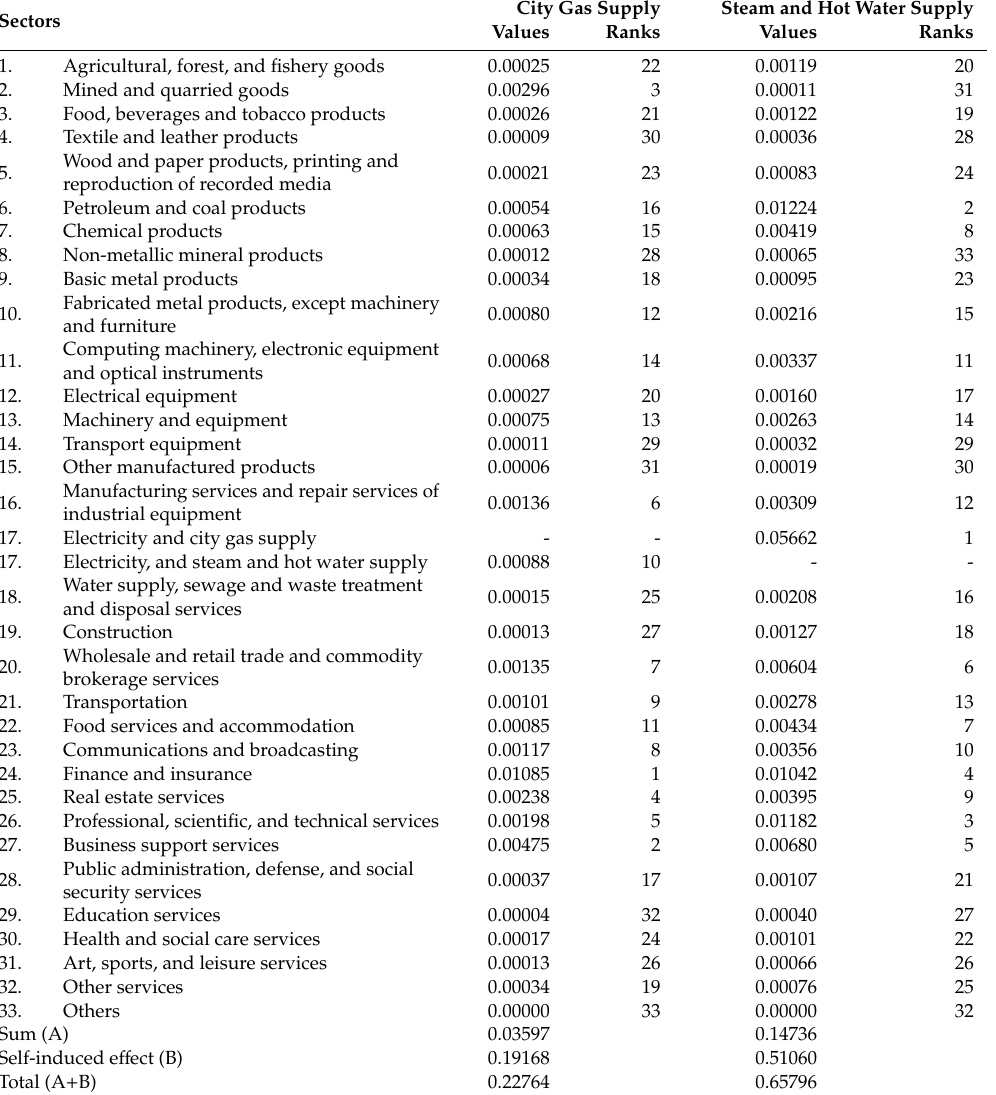
Table 3. Value-added creation e ff ects of steam and hot water supply and city gas supply